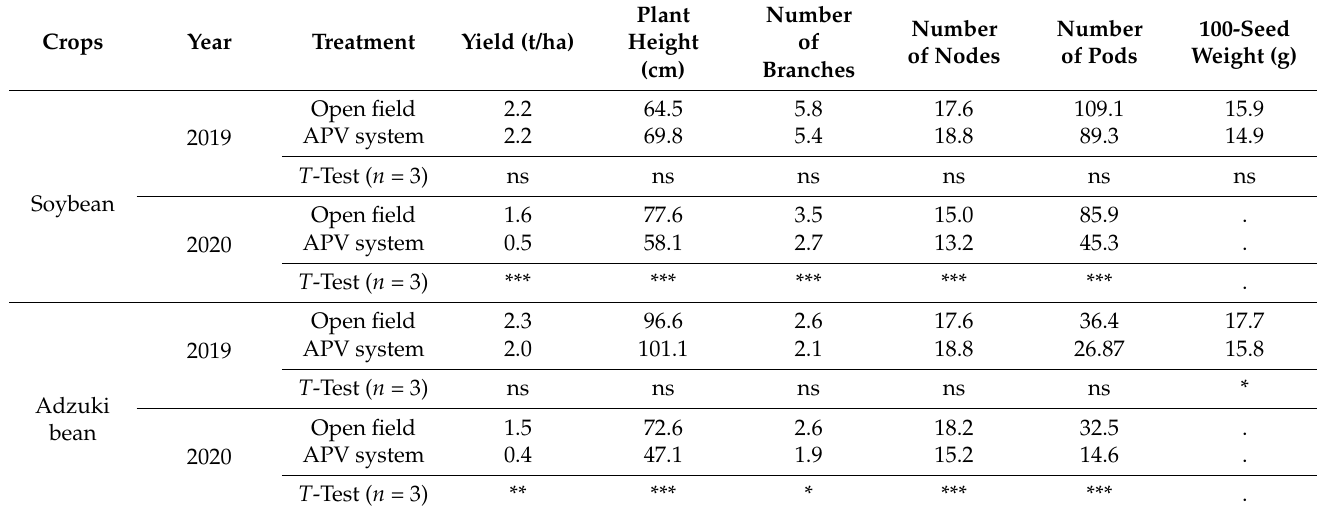
Table 2. Agronomic traits and seed yields of soybean and adzuki bean between the agro-photovoltaic system and the open field.